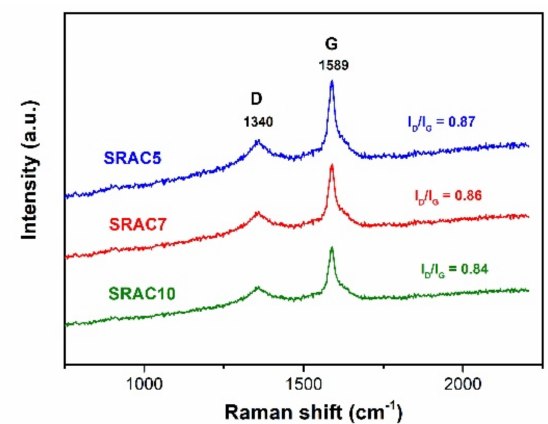
Figure 3. Raman spectra of the as-prepared SRACs.